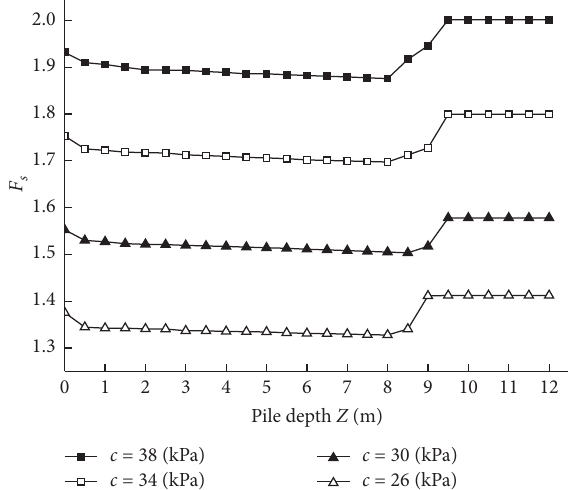
Figure 6: Effects of soil cohesion on the stability of 3D